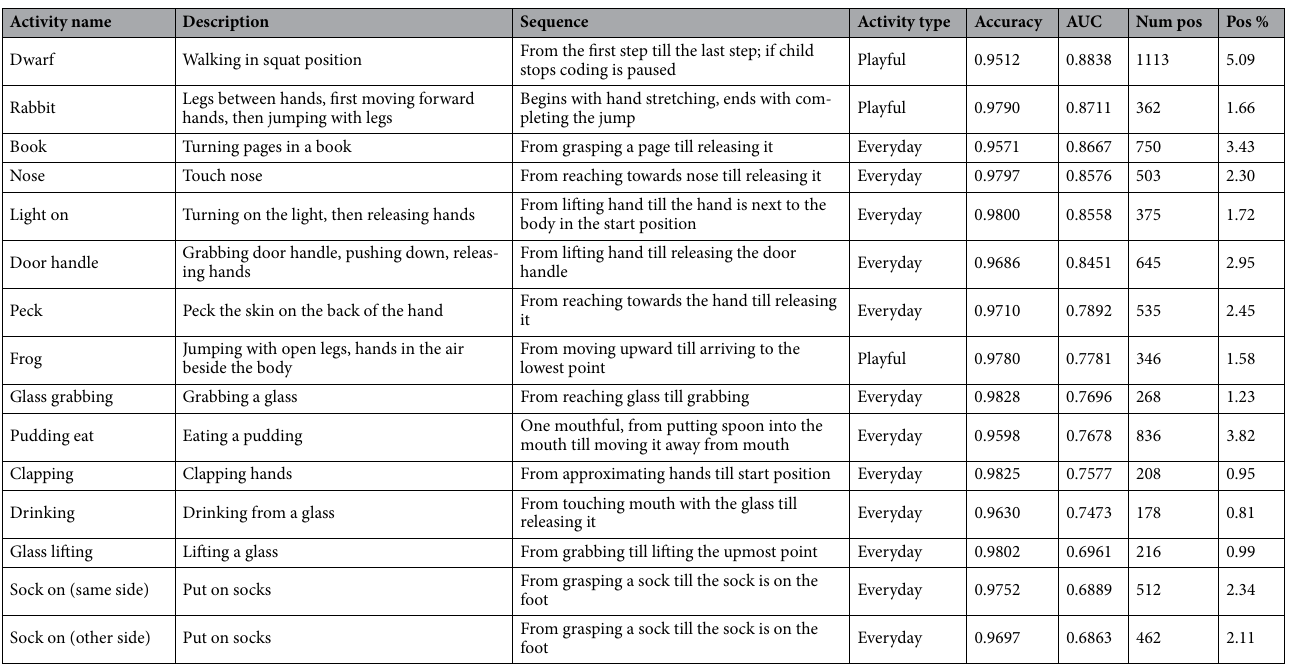
Table 2. The Budapest activity test battery (BATB) and performance of the machine learning methods. The table was sorted by AUC with the highest recognition figures at the top. Num pos is the number of occurrences of a given activity in the